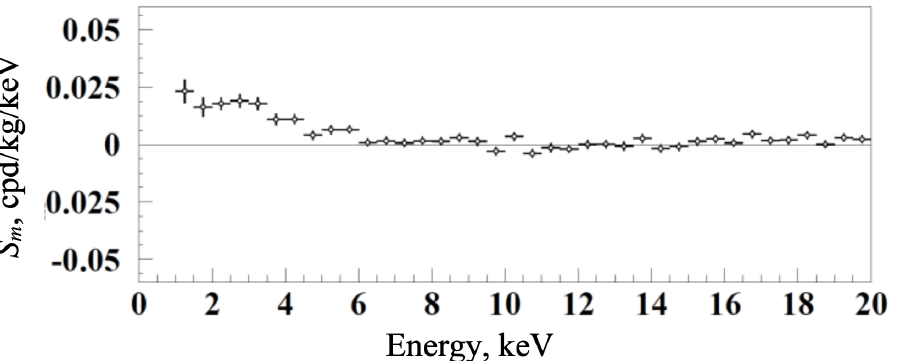
Figure 2. Modulation amplitudes, S m , for the whole data sets: DAMA/NaI, DAMA/LIBRA–phase1 and DAMA/LIBRA–phase2 (total exposure 2.46 tons × year) above 2 keV; below 2 keV only the DAMA/LIBRA–phase2 exposure (1.13 tons × year) is available and used. The energy bin ∆ E is 0.5 keV. A clear modulation is present in the lowest energy region, while S m values compatible with zero are present just above. In fact, the S m values in the (6–20) keV energy interval have random fluctuations around zero with χ 2 equal to 42.6 for 28 degrees-of-freedom. (upper tail probability of 4%). Reprinted from Ref. [41] under Copyright Permission of the Institute for Nuclear Research of the National Academy of Sciences of